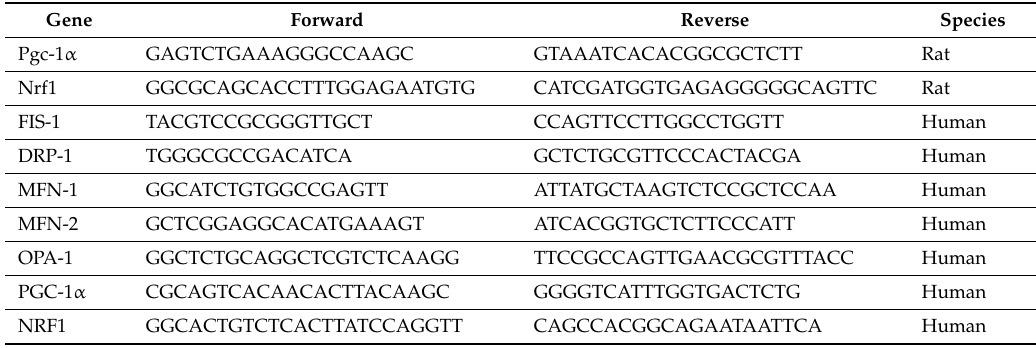
Table 1. Quantitative real-time PCR primer